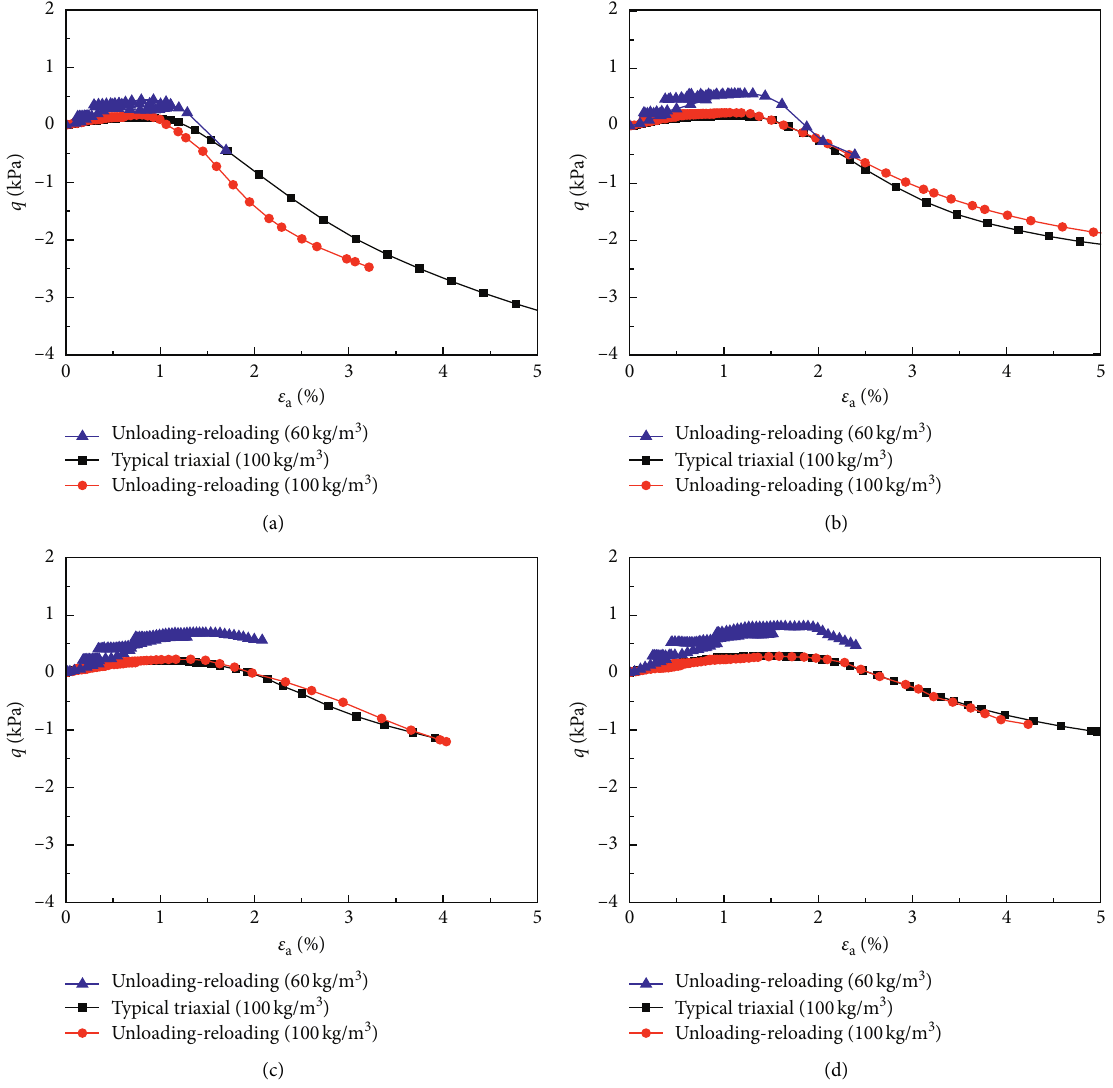
Figure 4: Volumetric strain-axial strain curves for different confining pressures of LCSG material. (a) 300kPa. (b) 600kPa. (c) 900kPa. (d) 1200kPa.